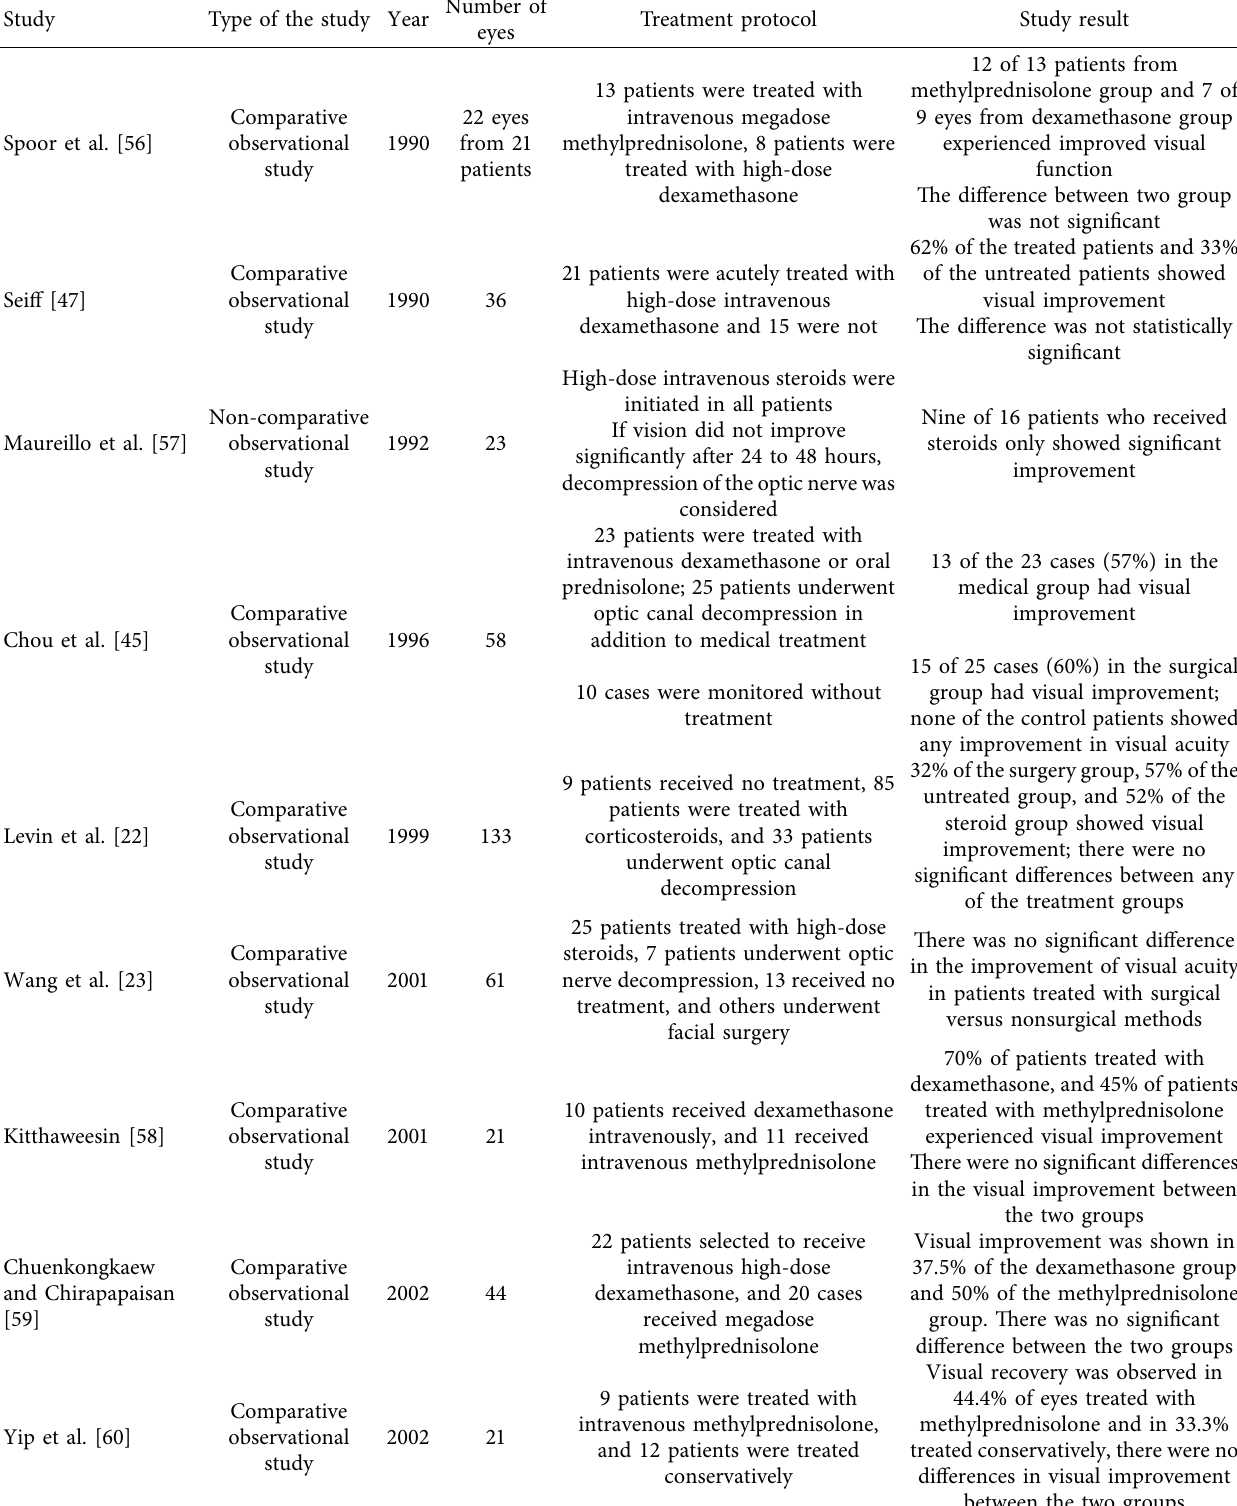
Table 1: Summary of the studies on the effectiveness of steroids for the treatment of